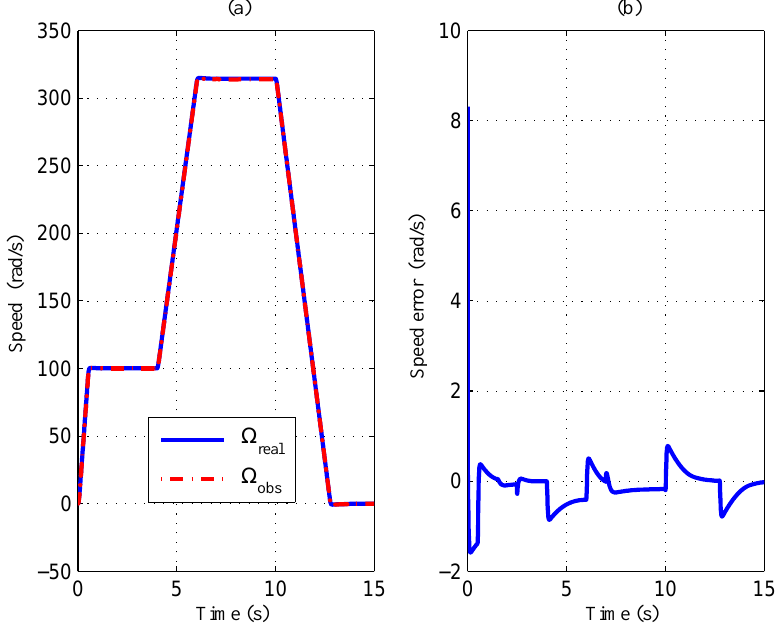
Figure 9. Robustness w.r.t. +30% R s : ( a ) observed and measured speeds; and ( b ) speed error.